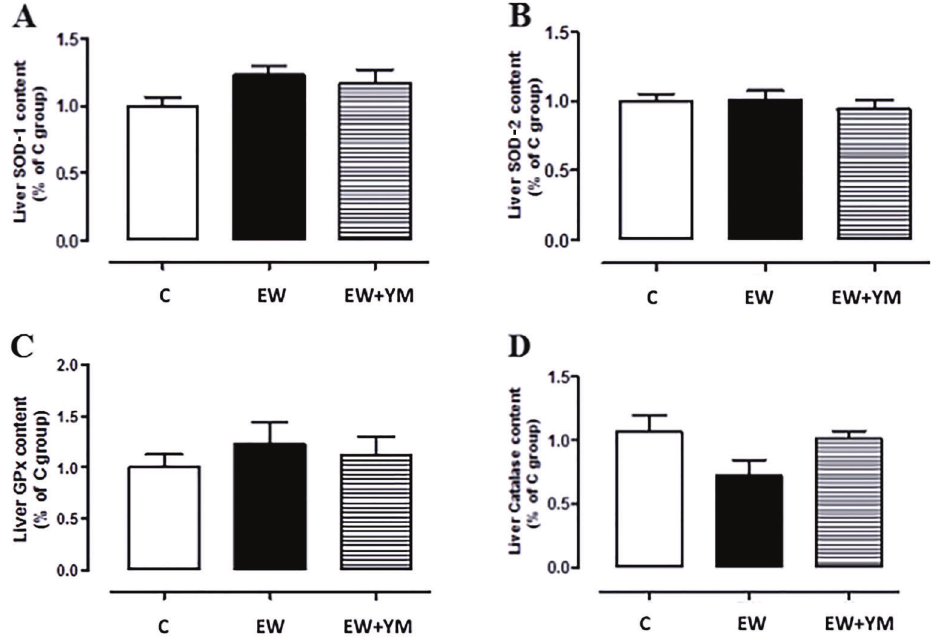
Figure 1. Early weaning and yerba mate treatment did not change liver antioxidant enzymes content. A , superoxide dismutase 1 (SOD-1), B , superoxide dismutase 2 (SOD-2), C, glutathione peroxidase (GPx), and D , catalase protein content in the liver at postnatal day 180 of adult rats that were normally breastfed for 21 days (C), early weaned (EW), or EW that received yerba mate for 30 days (EW + YM). Data are reported as means ± SE of 10 rats per group